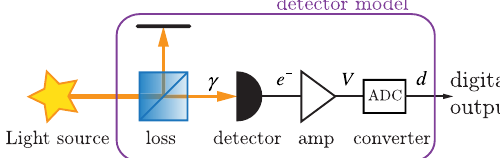
FIG. 1. A detector, or indeed each pixel of an image sensor, can be modeled as having 100% efficiency but are preceded by a lossy element (beam splitter) with transmission η . For each absorbed photon, the detector generates an electron. This charge is then converted into a voltage and amplified before being digitized and sent to further processing, i.e., a randomness extraction stage.